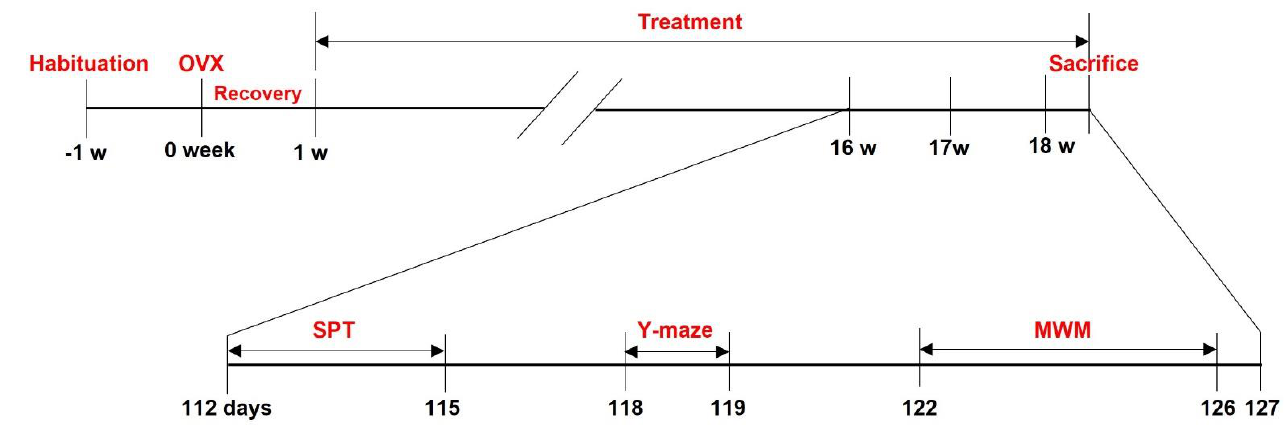
Figure 1. Schematic drawing of the experimental